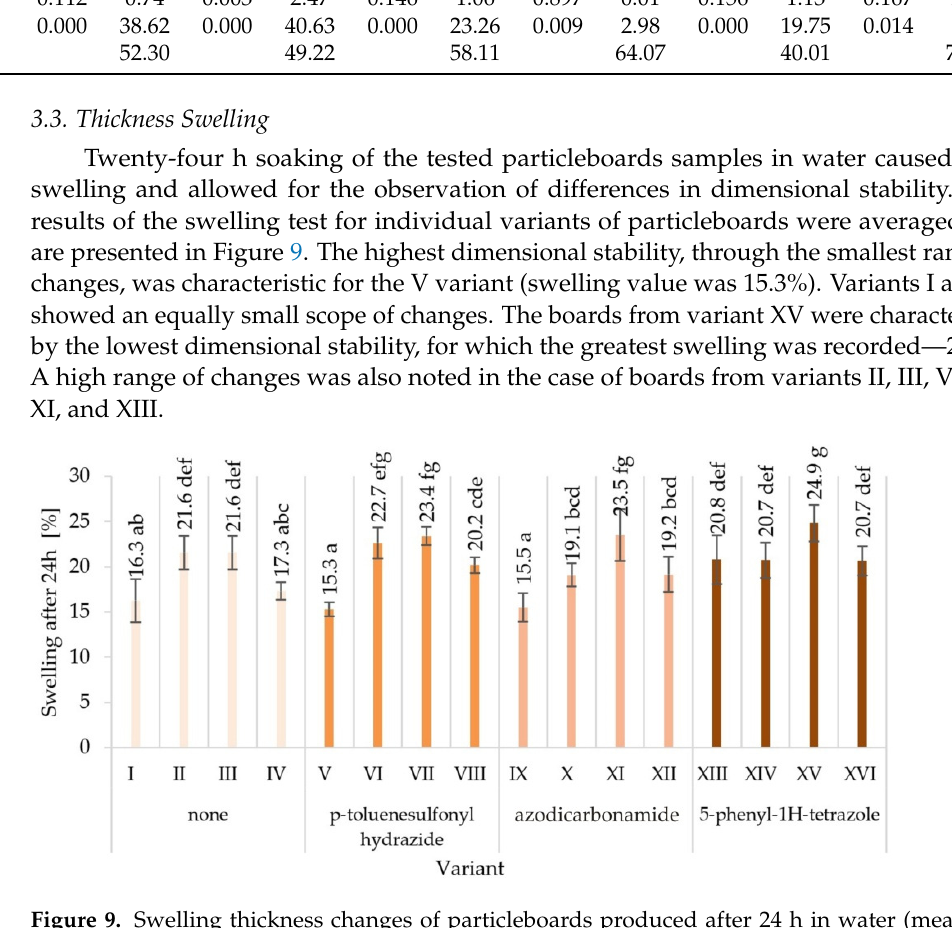
Figure 9. Swelling thickness changes of particleboards produced after 24 h in water (mean and standard deviation, a, b, c, …—homogeneous groups determined by the Tukey test; different letters denote a significant difference; means followed by the same letter do not statistically differ from each other ( p < 0.05) according to Tukey’s post hoc test).